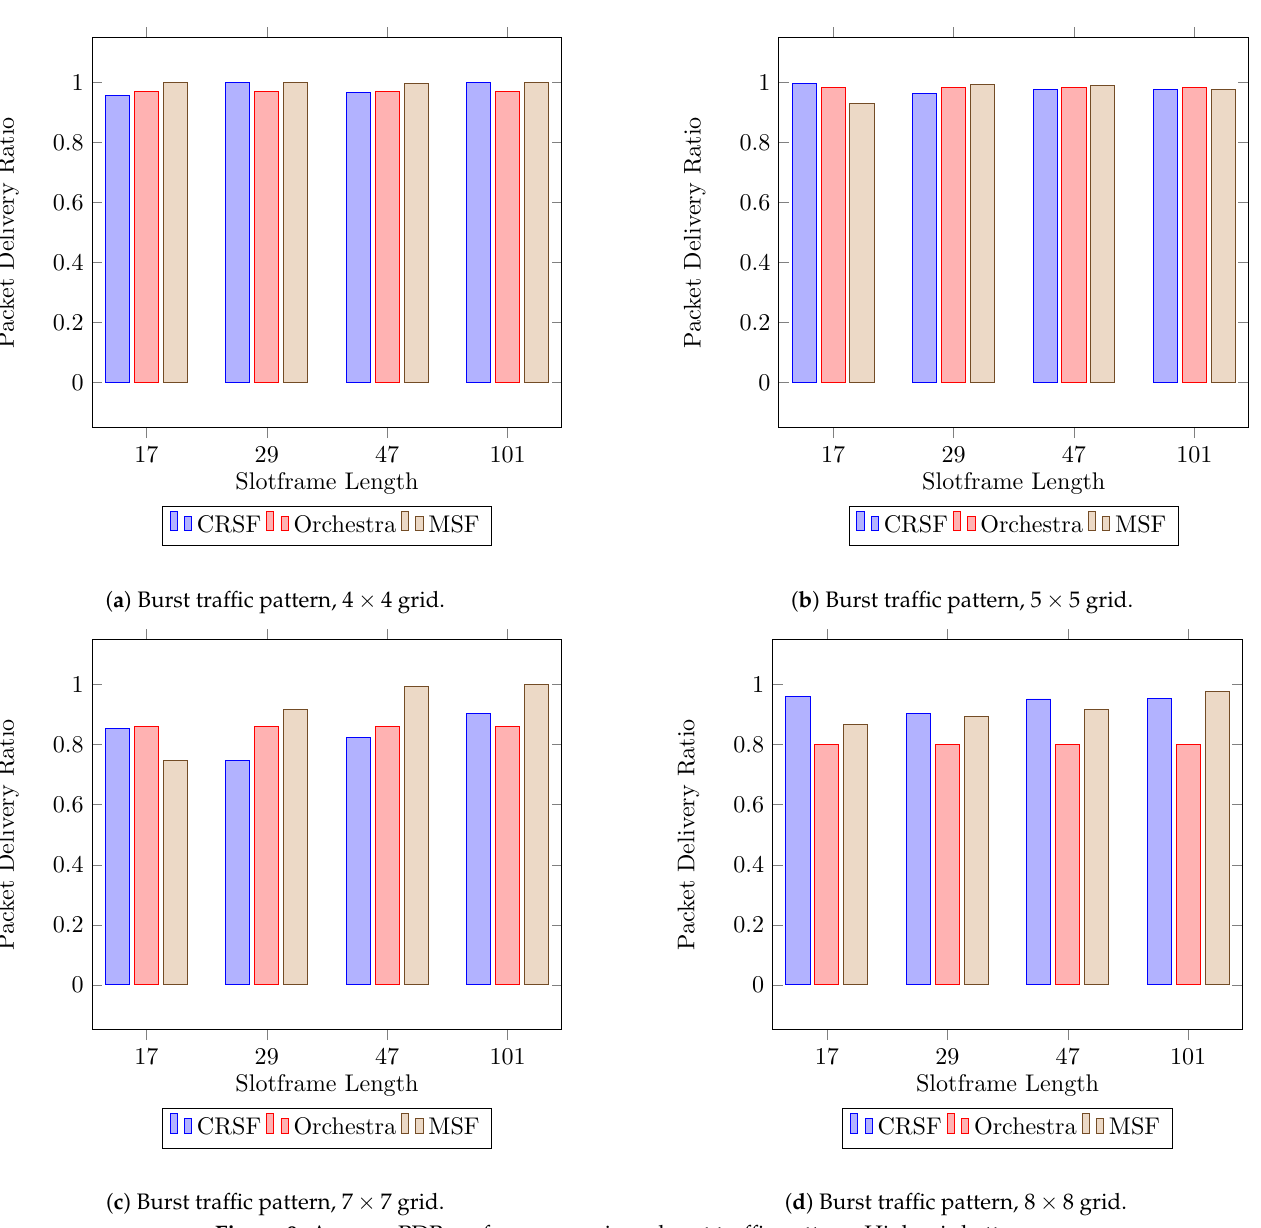
( d ) Burst traffic pattern, 8 × 8 grid. Figure 9. Average PDR performance using a burst traffic pattern. Higher is better. The high PDR achieved by the CRSF in burst traffic scenarios is accompanied by larger latency compared to Orchestra and the MSF, as can be seen in Figure 10a,b (see Table A6 in Appendix A for the supplementary data). The CRSF shows a particularly large end-to-end latency in a 7 × 7 topology with slotframe lengths of 47 and 101 (Figure 10c). This, however, is not always true for larger node deployments since the CRSF behaves better in 8 × 8 deployments (Figure